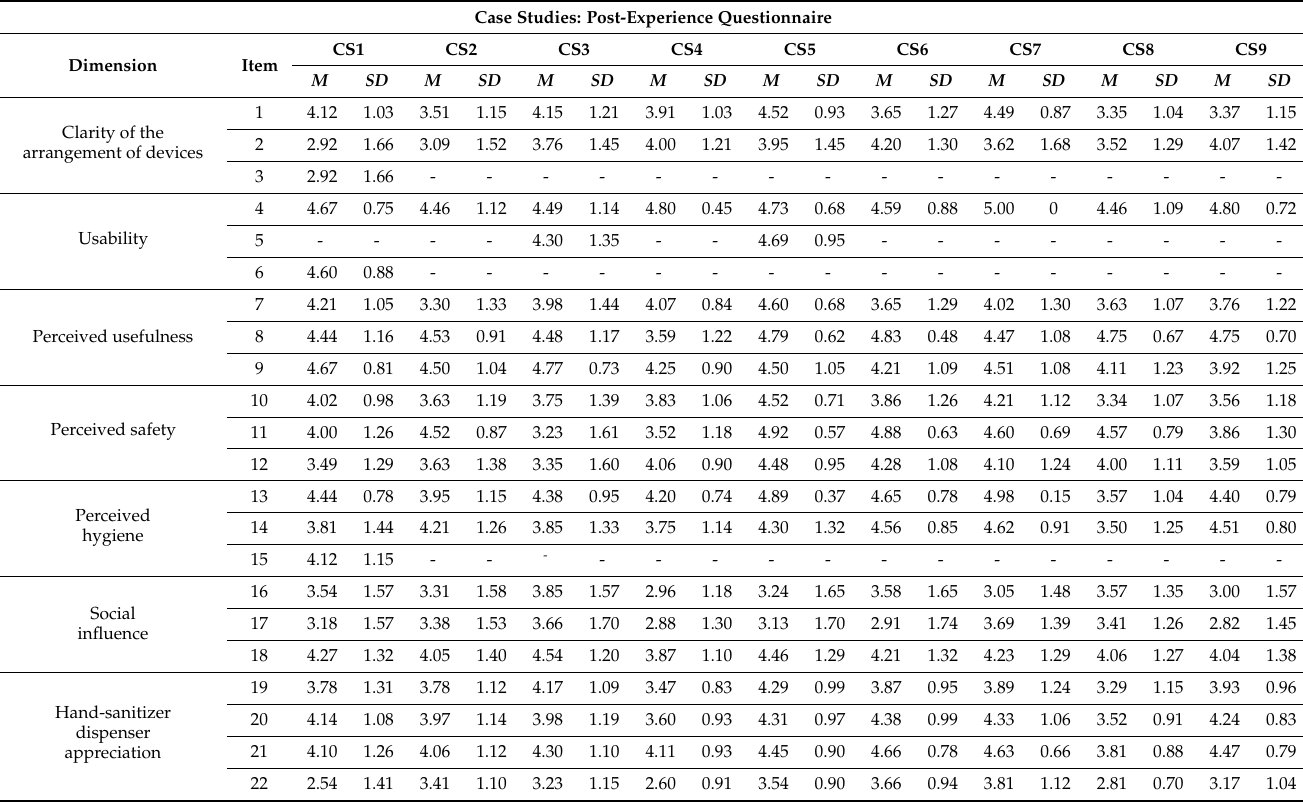
Table A6. Table illustrating the mean ( M ) and standard deviation ( SD ) of the post-experience questionnaire for each single case study (CS1–CS9). Own